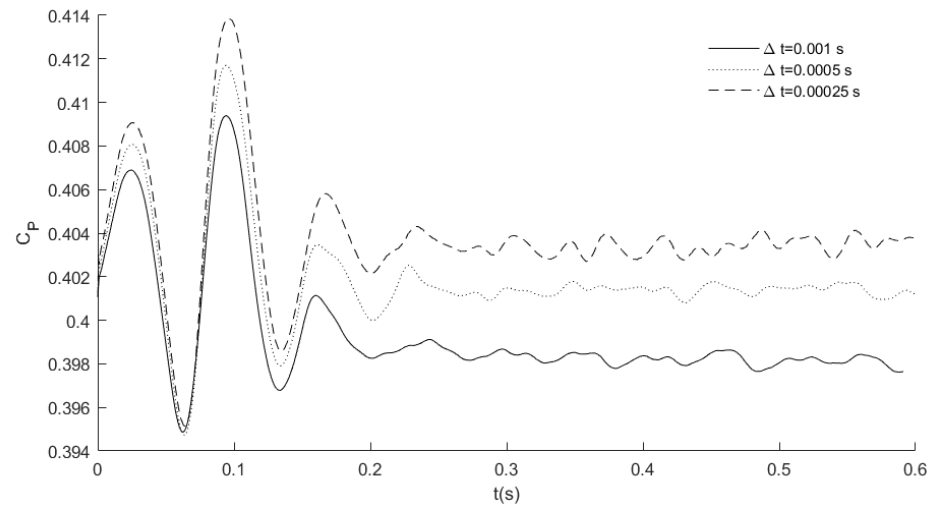
Figure 5. Effect of time-step size on the computed C P at λ =